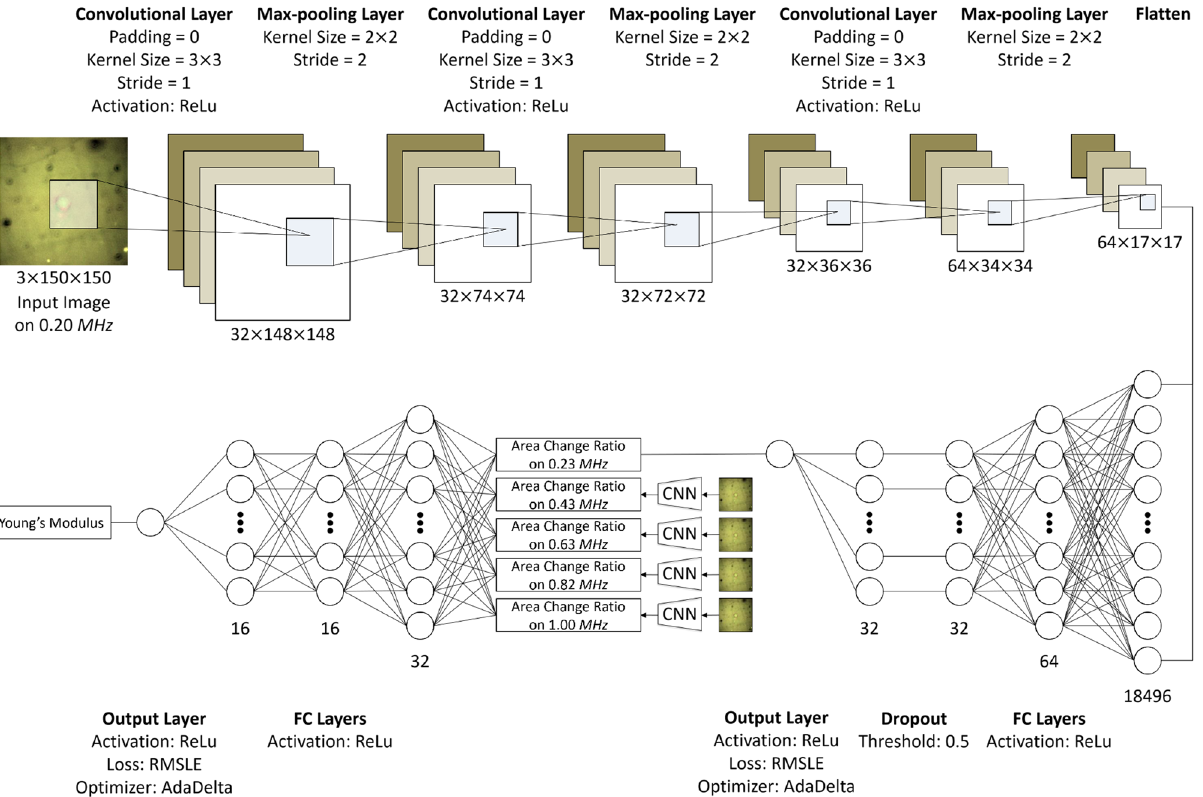
Figure 8. Proposed models for measuring area change ratios and estimating non-linear elastic moduli. The CNN model for area changes consists of three 2-D convolutional layers and two fully connected layers. The MLP model for non-linear elastic moduli consists of two fully connected